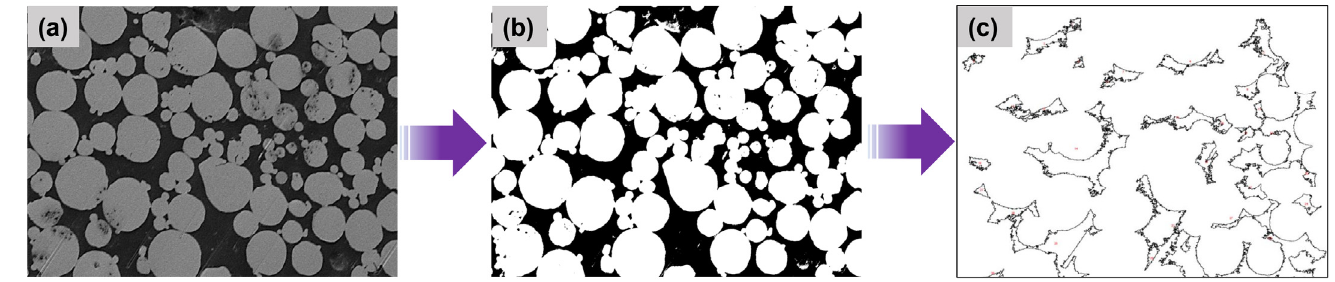
Figure 3. The image processing for pore areas and particle size measurement using ImageJ. ( a ) original SEM image; ( b ) SEM image converted into a binary image; ( c ) high-accuracy size measurement was ensured via the image processing method.